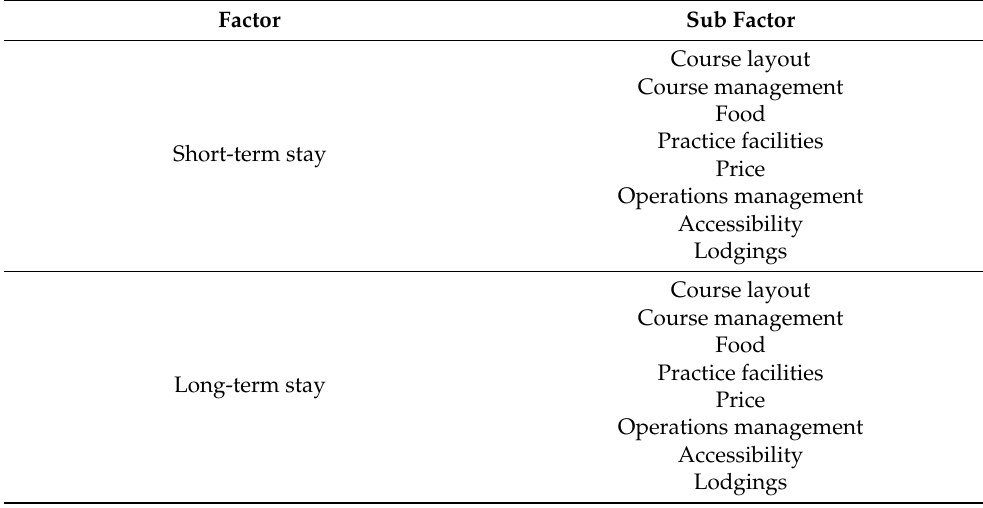
Table 11. Subcategorization of golf course choice attributes for qualitative